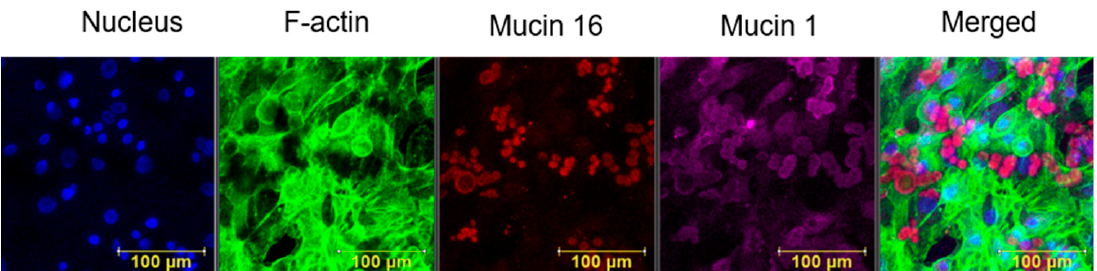
Figure 1. Representative projection of a cultured primary HCEC. Immunofluorescence staining: nucleus (blue), F-actin (green), membrane-tethered Mucin16 (red) and membrane-tethered Mucin1 (purple). Representative projection images obtained immediately after exposure to WSS for durations of T 15 and T 30 are shown in Figures 2 and 3, respectively. These results are